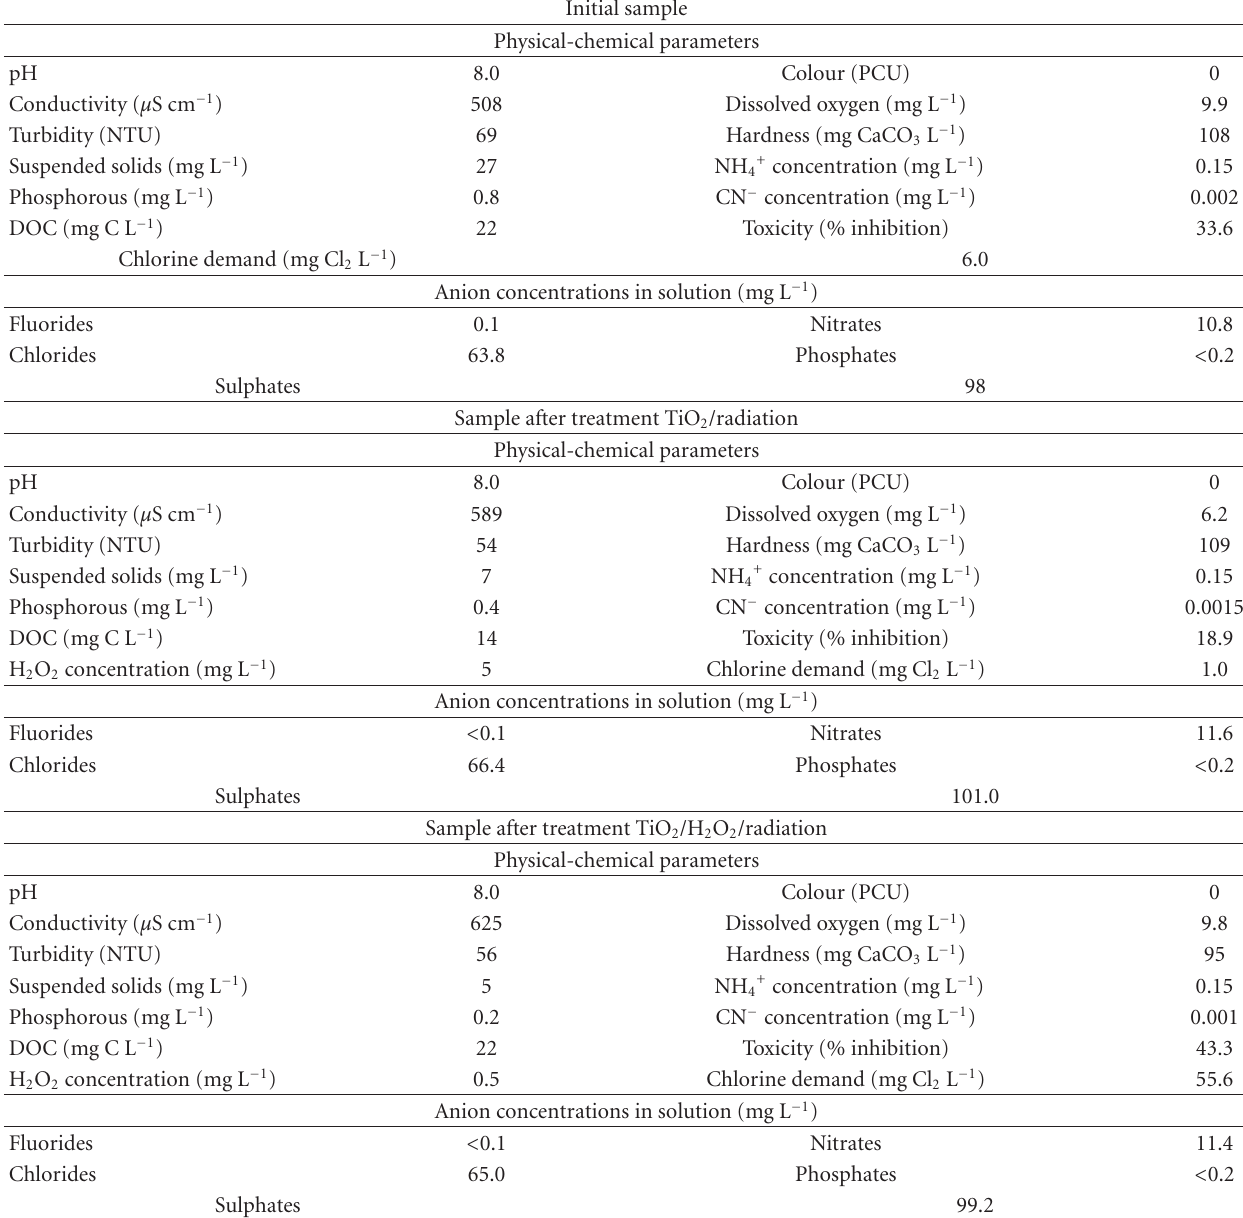
Table 4: Characterization of samples of surface w´ater fortified with pesticides in photocatalytic